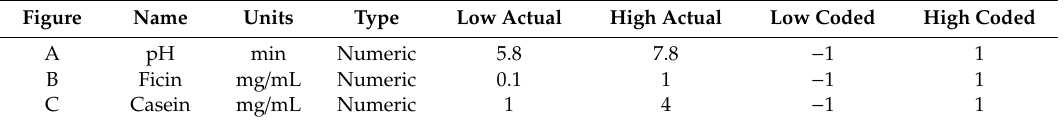
Table 1. Coded and actual values of significant factors used in central composite design (CCD).